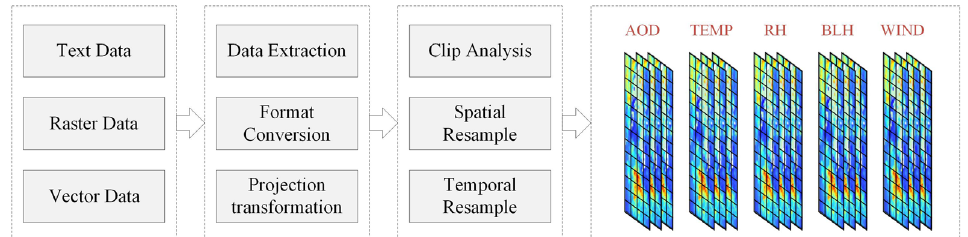
Figure 4. Computational workflow of data processing. Input data include text, raster, and vector formats, with the following processing: (1) input data need to be directionally extracted to omit other information from original format (data extraction), and converted to a uniform format (format conversion, for Esri geodatabase) and coordinate system (projection transformation, for EPSG 4549); (2) integrate these data into a unified 10 × 10 km 2 grid system on a spatial scale (clip analysis, spatial resample) and unify monthly slices on a temporal scale (temporal resample).